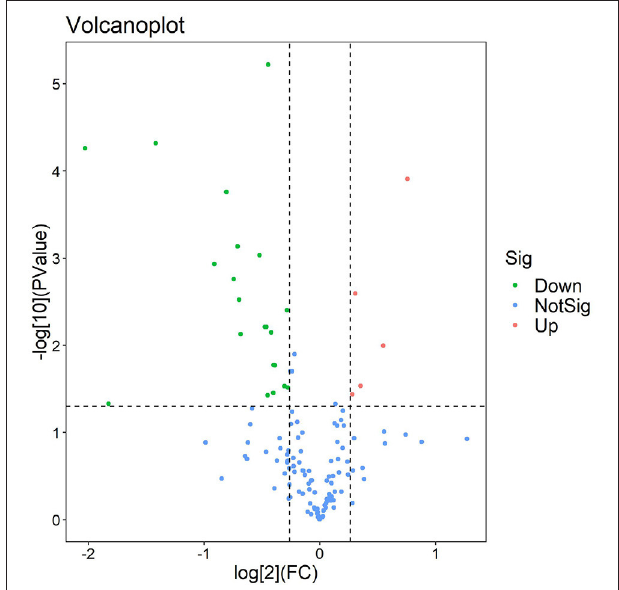
FIGURE 3 | Volcano plot of subclinical vitamin E deficiency vs. healthy control. The volcanic map was drawn using two factors, the fold change (Log2) between the two groups of samples and the p -value (–Log10) obtained by the t -test, to show the significant difference in the data of the two groups of samples. Red and green dots in the figure are proteins that are significantly differently expressed (1.2 times of fold change and 0.05 of p -value). Green dots are downregulated proteins, red dots are upregulated proteins, and blue dots are proteins that have no significant